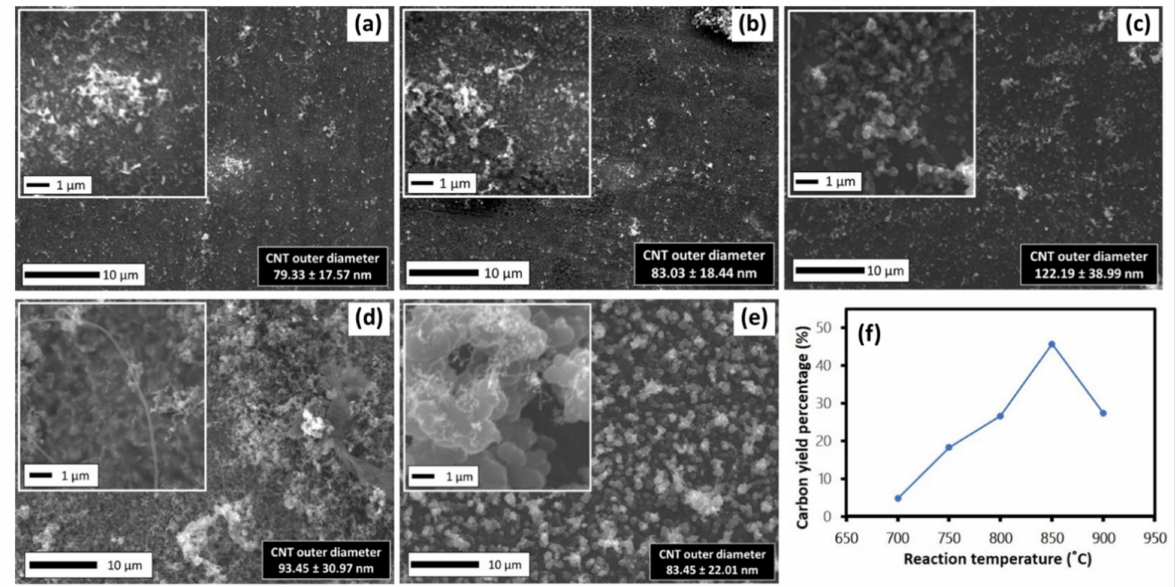
Figure 9. SEM images of samples synthesized at various sample reaction temperatures of ( a ) 700, ( b ) 750, ( c ) 800, ( d ) 850 and ( e ) 900 ◦ C, and ( f ) carbon yield percentage.